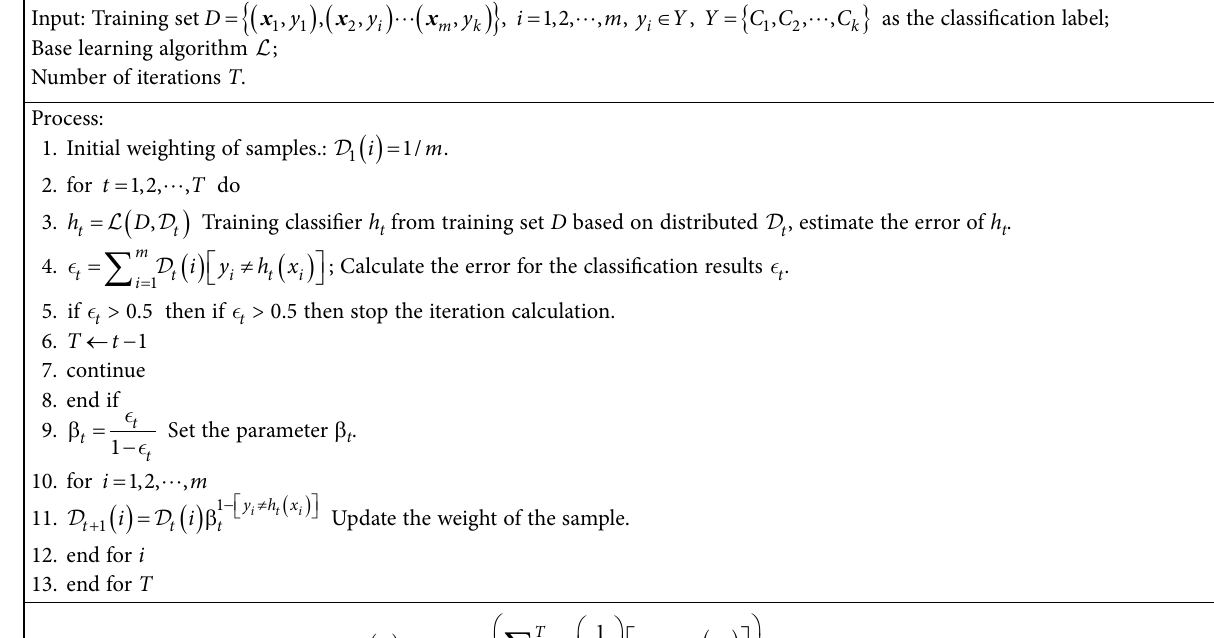
Table 7. AdaBoost.M1 algorithm process (Weiss & Provost, 2003)